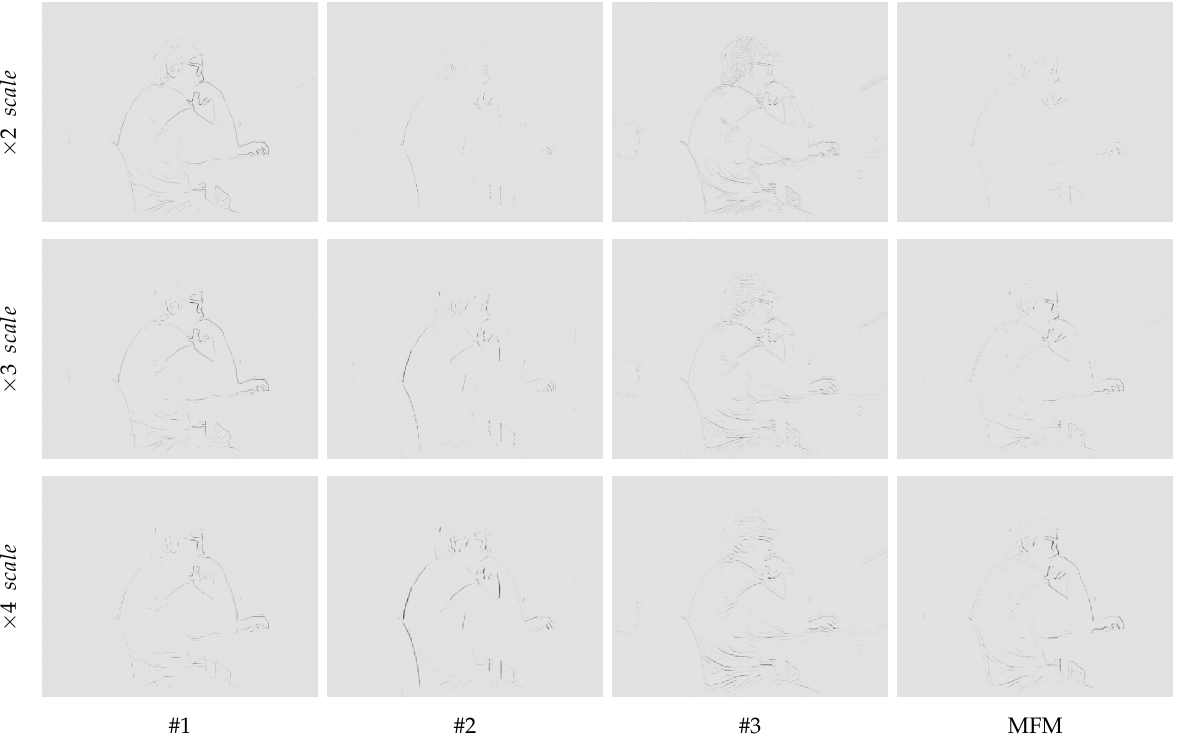
Figure 8. Examples of confidence maps (row: scale × 2, × 3, and × 4; column: from the #1, #2, and #3 sub-networks and the mixed feature module (MFM)).